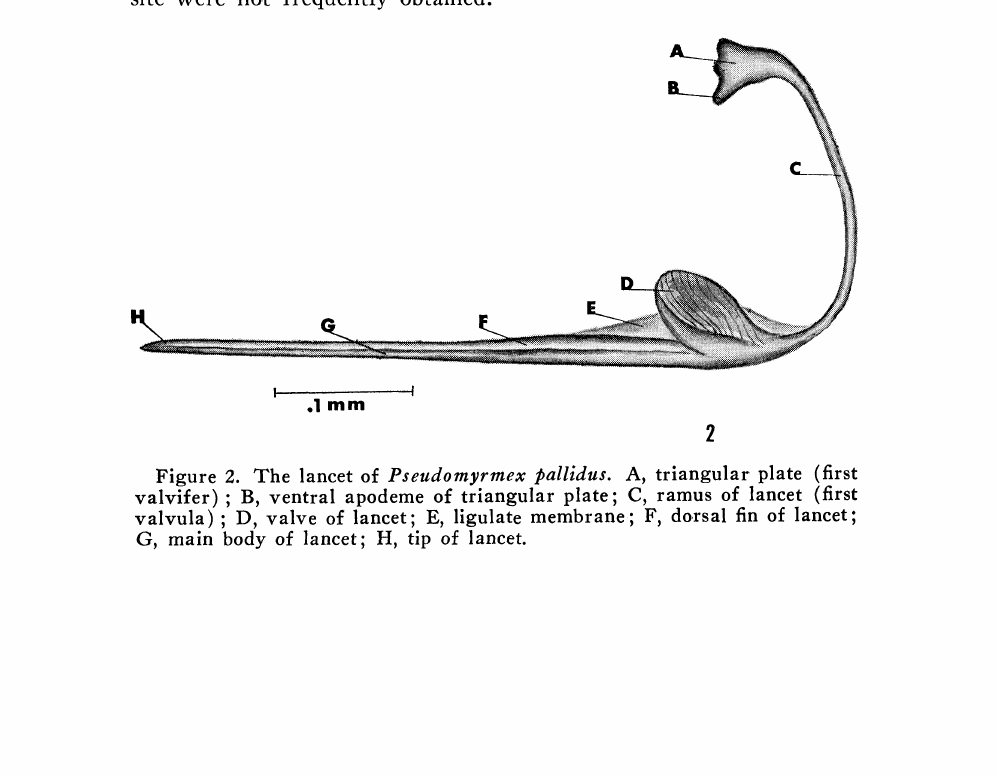
Figure 2. The lancet of Pseudomyrmex #allidus. A, triangular plate (first valvifer) B, ventral apodeme of triangular plate; (2, ramus of lancet (first valvula) D, valve of lancet; E, ligulate membrane; F, do.rsal fin of lancet; (3, main body of lancet; H, tip of